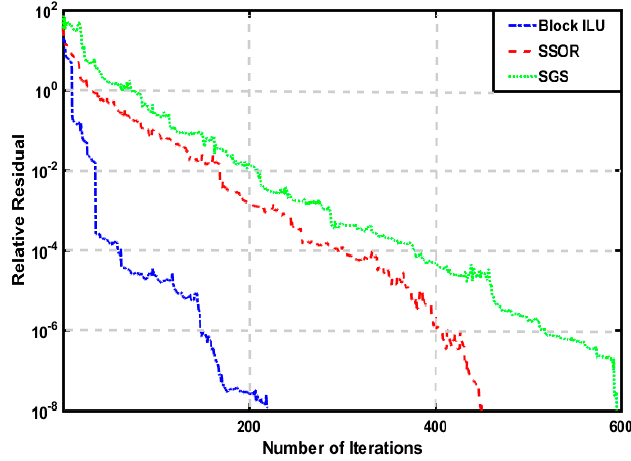
Figure 12. The convergence plot of different preconditioners with BiCGStab for the model 3.